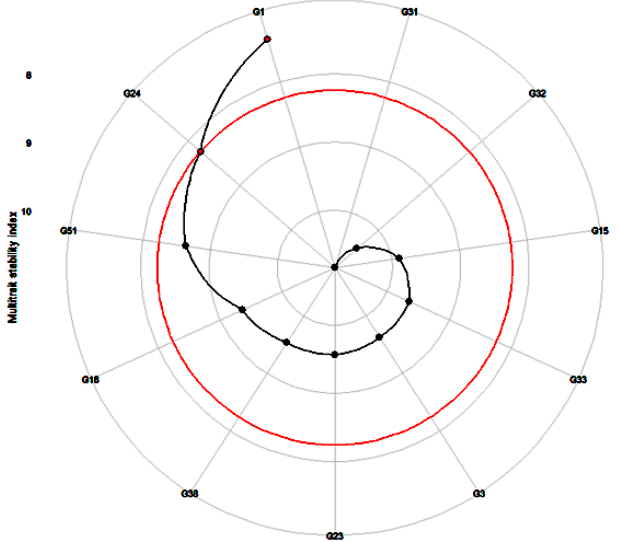
Figure 4. Prediction of highly stable and best-performing genotypes (G1 = ICMH-177111 and G24 = ICMX-207137) across the 52 metabolites in pearl millet lines tested in five locations. (G3 = ICMX- 207207, G15 = ICMX-207076, G18 = ICMX-207094, G23 = ICMX-207136, G31 = ICMX-207171, G32 = ICMX-207181, G33 = ICMX-207183, G38 = ICMX-207190, G51 = ICMX-207192) .